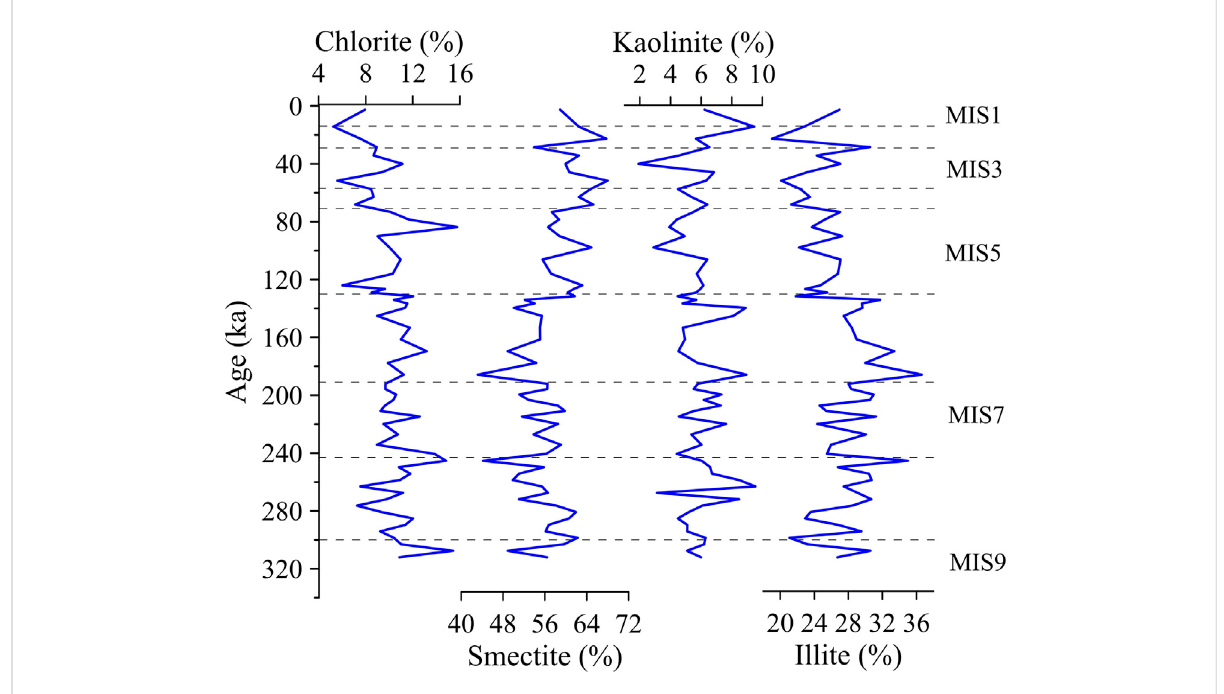
FIGURE 8 Relative contributions of the four major clay minerals to the clay fraction of sediments in core H10.